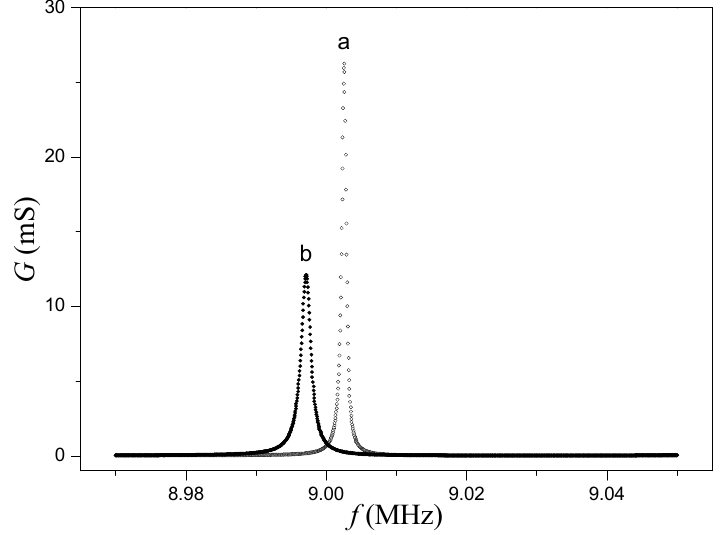
Table 1. Comparison of bare and modified QCM in air by PQCI.